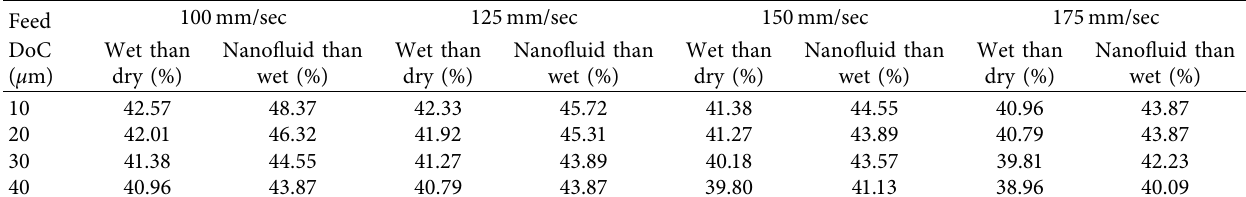
Table 9: Temperature reduction by coolant and lubricant at constant